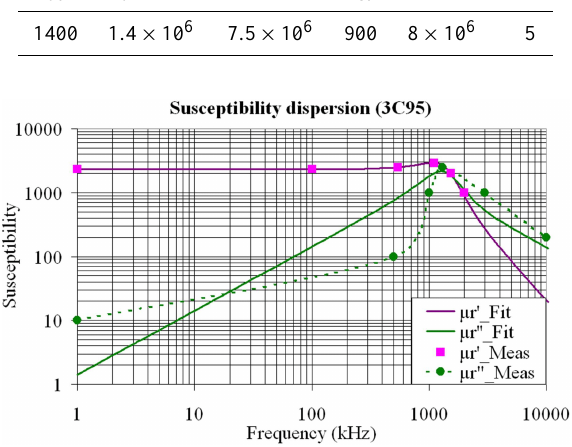
Figure 6. Measured ( µ (cid:48) r _Meas and µ (cid:48)(cid:48) r _Meas) and fitted ( µ (cid:48) r _Fit and µ (cid:48)(cid:48) r _Fit) susceptibility dispersions of 3C95 Mn–Zn ferrite.